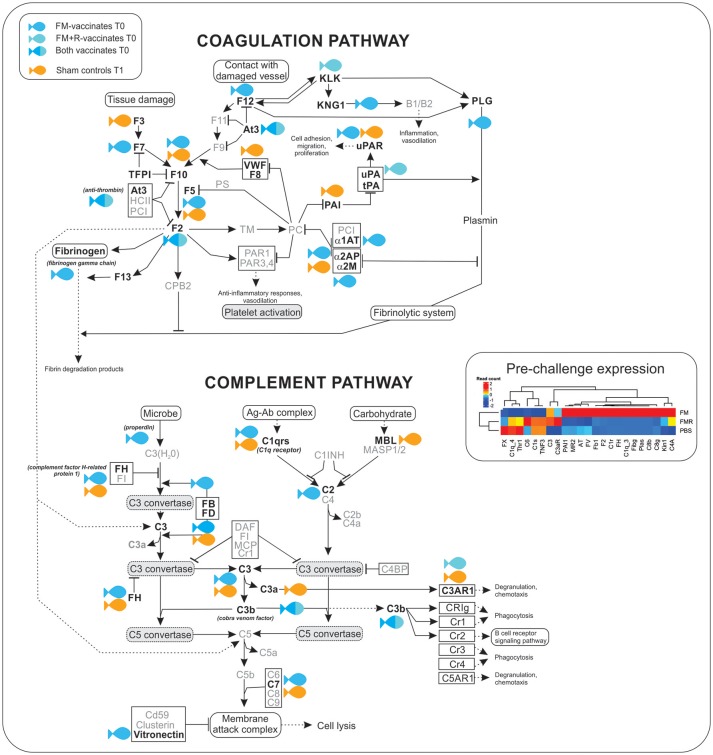
Transcripts involved in the complement and coagulation cascade were significantly up-regulated (shown in bold) in ForteMicro®- (blue symbol) and ForteMicro®+Renogen®-vaccinated (cyan symbol) fish prior to infection with Asal (517 dppv). In contrast, after infection there was down-regulation of genes in this pathway while in PBS-injected controls (orange symbol), these genes were up-regulated.